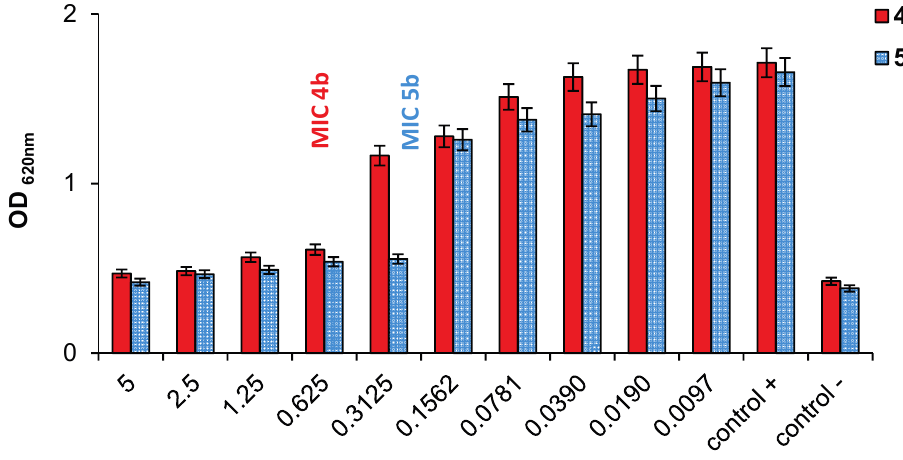
Figure 2. In vitro antibacterial activities. Minimal inhibition concentration (MIC) value of 4b and 5b against B. cereus